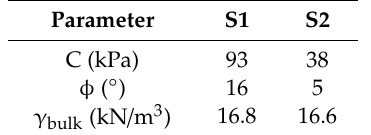
Table 7. Unconsolidated undrained triaxial test result.